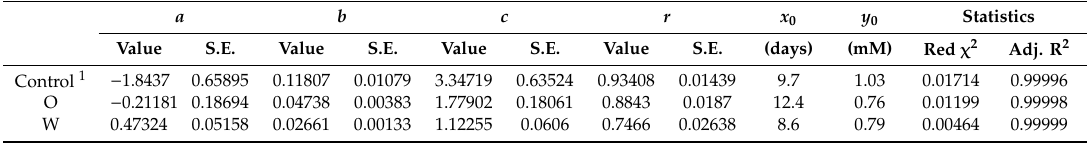
Table 1. Parameters and statistics of the Shah fitting models for the decay of hydroperoxides in O / W emulsions, added with OPA, during the first 14 days of accelerated oxidation test with AAPH radical